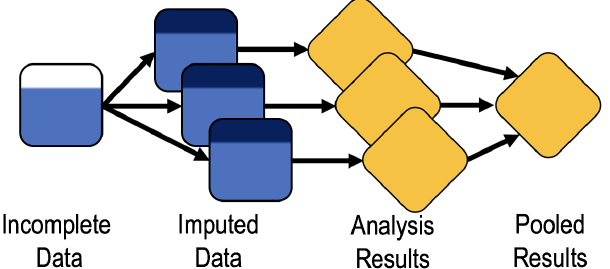
FIG. 4. The multiple imputation (MI) process. In the first step missing data (shown in white) are imputed (shown in dark blue) to create M complete data sets, with M ¼ 3 shown here. Then each complete imputed data set is analyzed using standard methods such as linear regression. Finally the results are pooled using Rubin ’ s